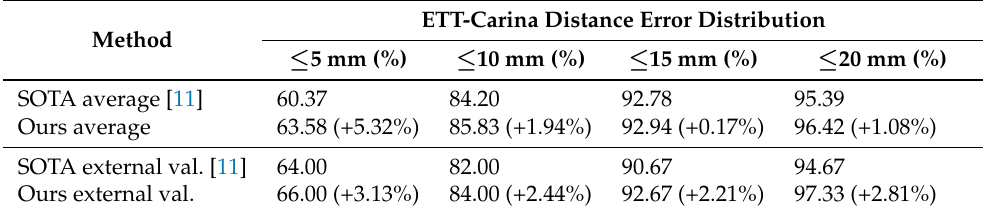
Table 10. The comparison results of error distribution on the ETT–Carina